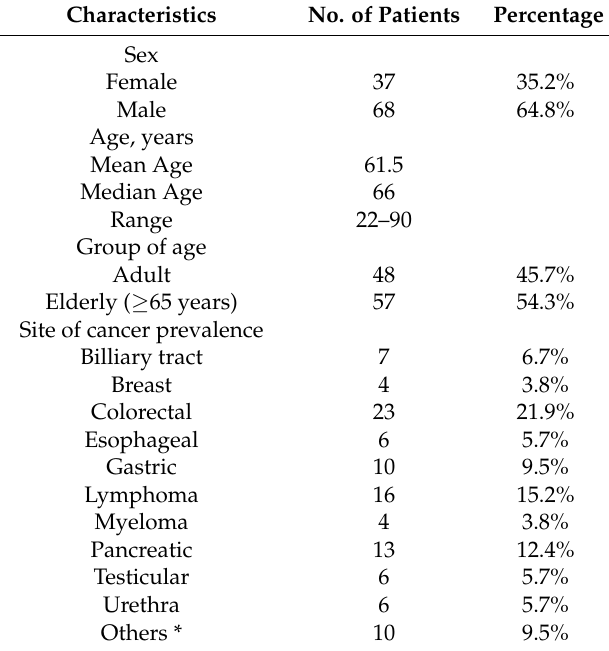
Table 2. Patient characteristics (N =